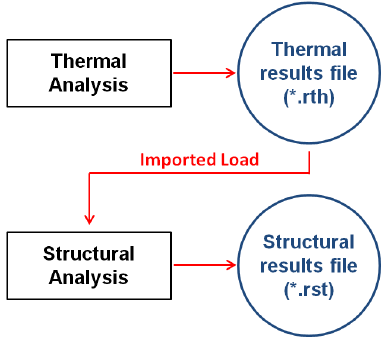
FIG. 14. The data flow for a typical sequentially coupled thermo-structural analysis. Temperatures from the thermal analy- sis are applied as loads at different time steps in the structural